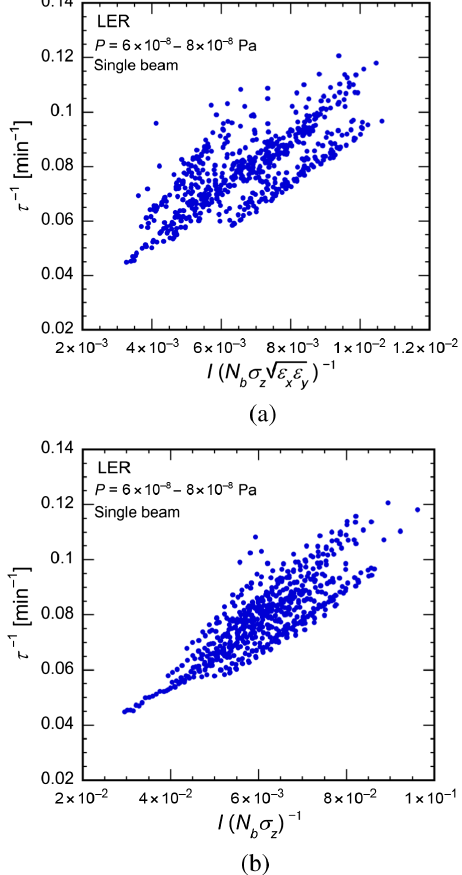
ffiffiffiffiffiffiffiffi p ε ε Þ and x y